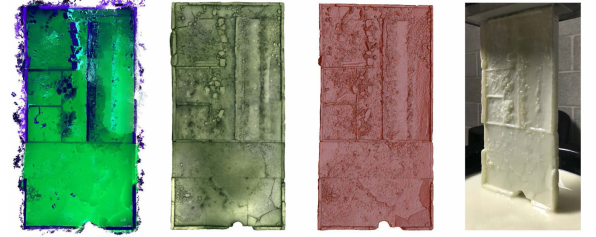
Figure 8. Image Based Models of The Cambell’s